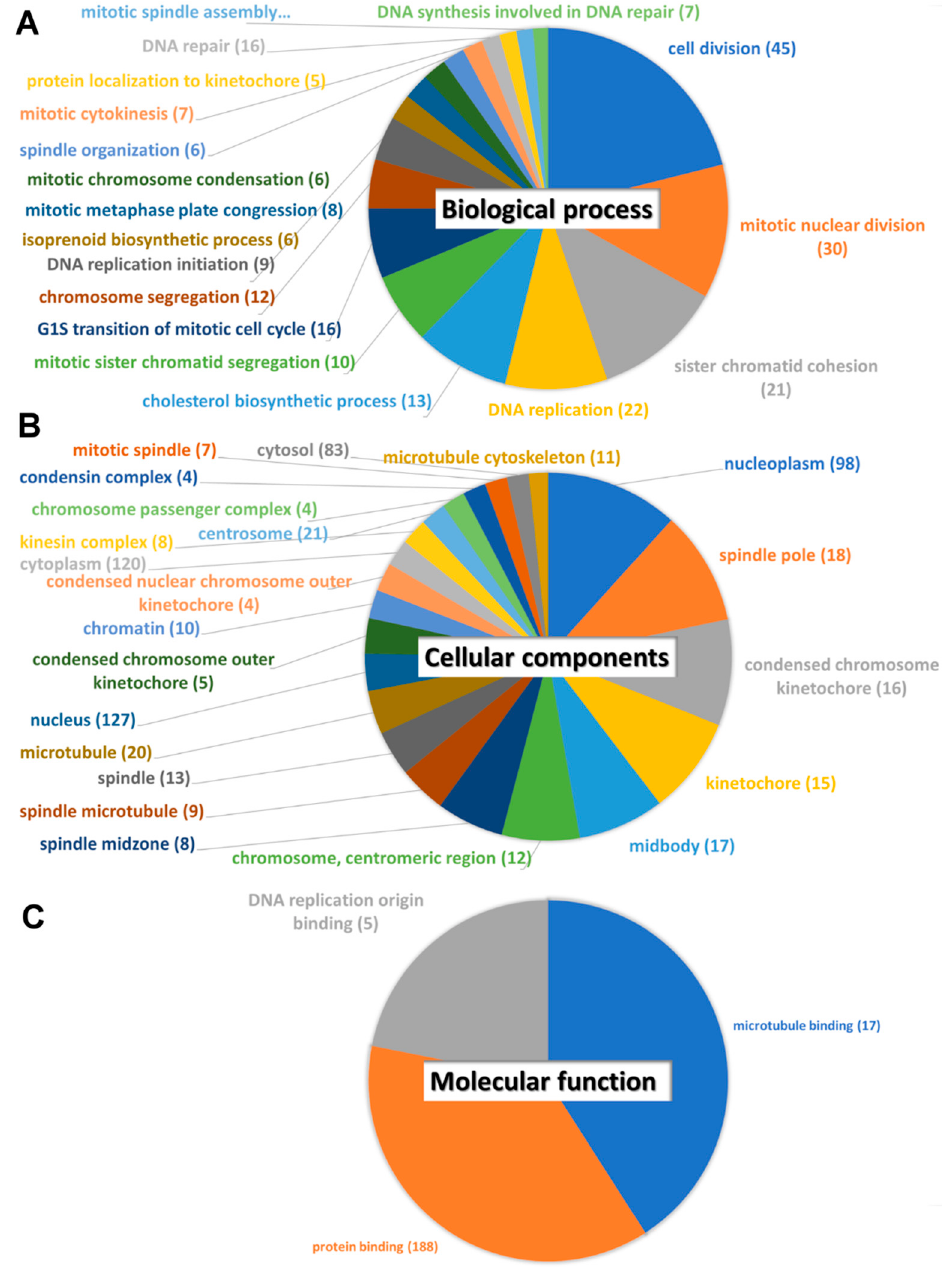
Figure 5. Possible mechanisms of the dysregulated genes in nintedanib-treated IPF fibroblasts analyzed by DAVID. ( A ) Biological process. ( B ) Cellular components. ( C ) Molecular functions. The counts of involved genes were showed as the number in. Pathways with a Bonferroni p value < 0.05 were considered significant. The area of each pathway reflected the significant level, based on their − log 10 (Bonferroni p ) values.